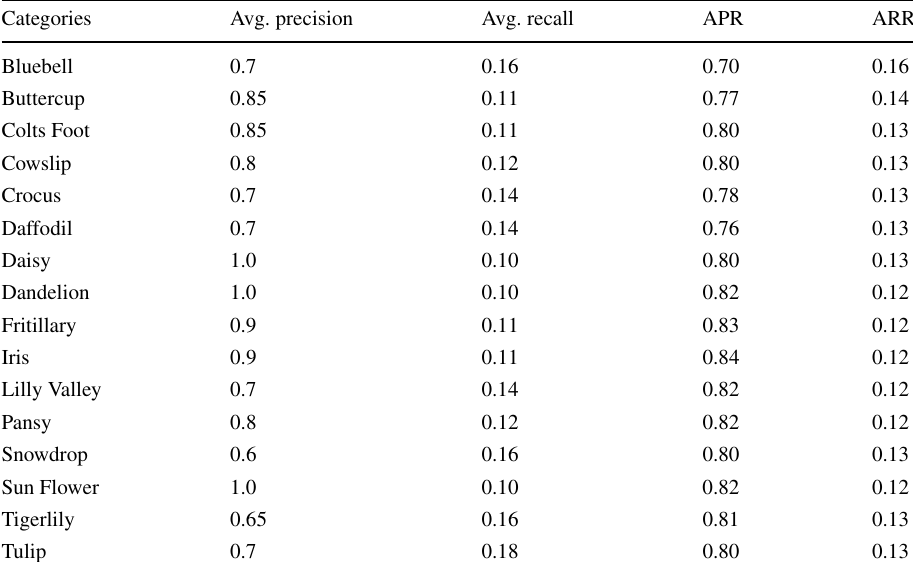
Table 3 Avg. precision, avg recall, APR, and ARR of 17 flower dataset